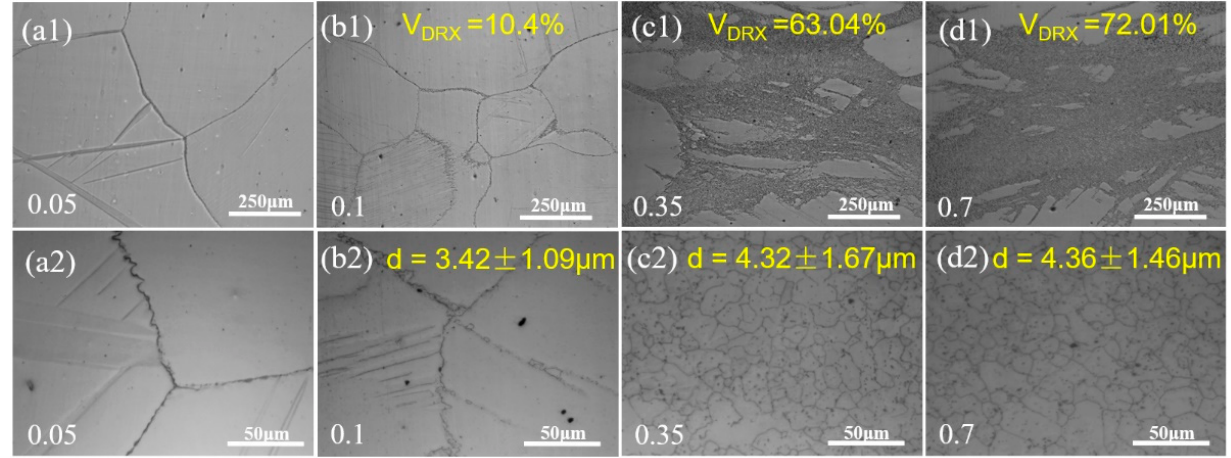
Figure 2. OM microstructure of Mg-5Zn alloy with different compression strains: ( a1 , a2 ) 0.05, ( b1 , b2 ) 0.1, ( c1 , c2 ) 0.35 and ( d1 , d2 ) 0.7.